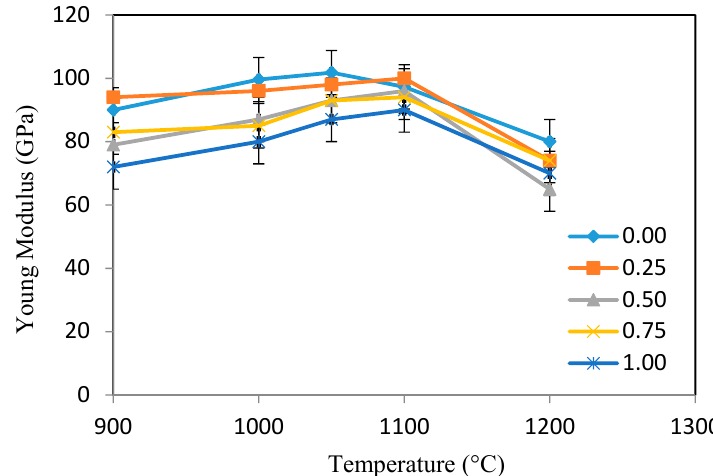
Figure 8. Numerical values of the Young’s modulus for Ca 10 − x K x (PO 4 ) 6 F (2 − 2 x ) (OH) x for 0 ≤ x ≤ 1 sintered at various temperatures.